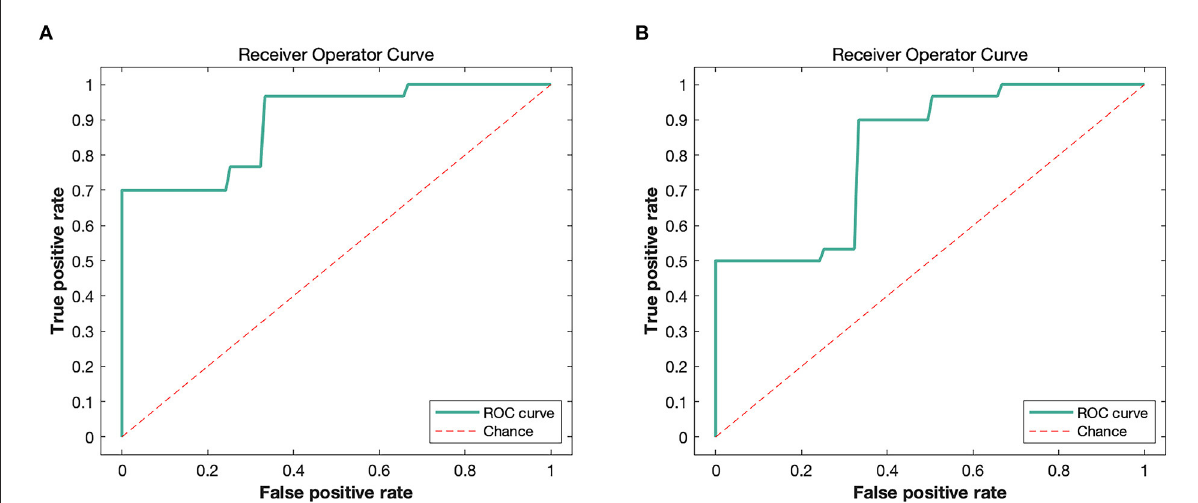
FIGURE4 The ROC curves of classifier performance of FA-based (A) and RD-based (B) . FA, fractional anisotropy; RD, radial diffusivity.